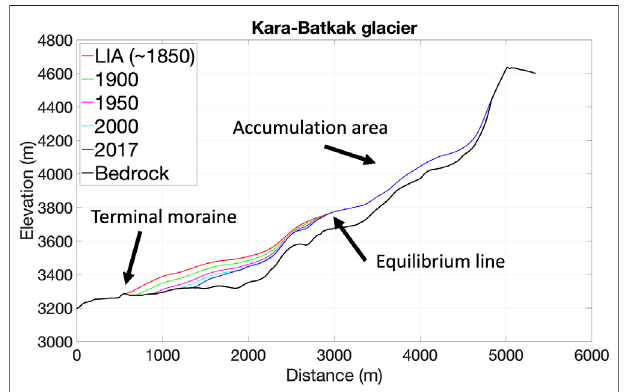
FIGURE 8 | Retreat of the Kara-Batkak glacier along the central fl owline since 1850.